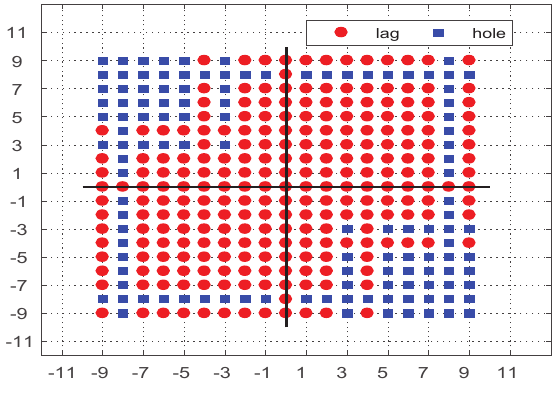
Figure 3. The structure of ¯ D